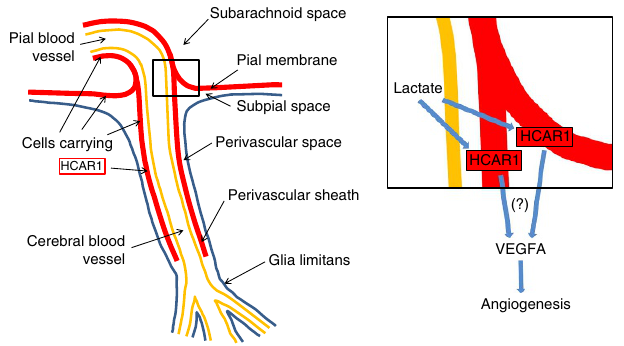
Figure 5 | Organization of cells that carry HCAR1 and of the angiogenic action of lactate. Blood-borne lactate from exercising muscle penetrates the blood vessel wall (yellow) through monocarboxylate transporters located in the vascular endothelium 53 (which represents the blood–brain barrier). Extravascular lactate (from blood or generated in the brain parenchyma upon neural activation) is freely diffusible in the perivascular/ subpial space, thereby bathing the leptomeningeal fibroblast-like cells carrying HCAR1 (red). Magnified inset indicates possible, yet unidentified (?), pathways leading from activation of HCAR1 in the cells in pia and perivascular sheaths to increased VEGFA and subsequent enhanced angiogenesis. The perivascular sheath extends as separate HCAR1-expressing pericyte-like cells at intracerebral microvessels, which may also contribute in the angiogenic process. Although apparently devoid of mRFP-HCAR1, other cells may possibly express low levels of HCAR1. HCAR1 may stimulate VEGFA in the same cells, or in other cells, through mediators. In addition to its angiogenic action, VEGFA has neurotrophic effects 11 . Importantly, all blood to the brain parenchyma has to pass in close proximity to the perivascular sheath of HCAR1-carrying cells and therefore can convey products released from these cells upon activation of the receptor; blood to the hippocampus passes through vessels (such as the ones shown in Fig. 3i) entering in the hippocampal fissure, an extension of the pia mater that penetrates deep into the centre of the hippocampal formation. (The anatomical sketch is based on ref.